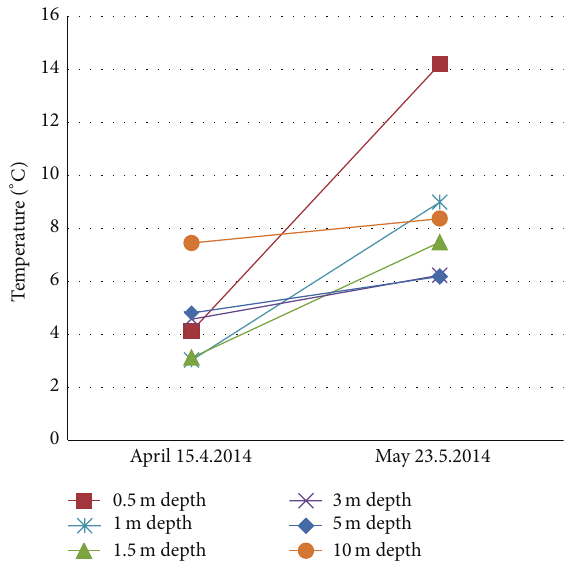
Figure 11: Temperatures under the